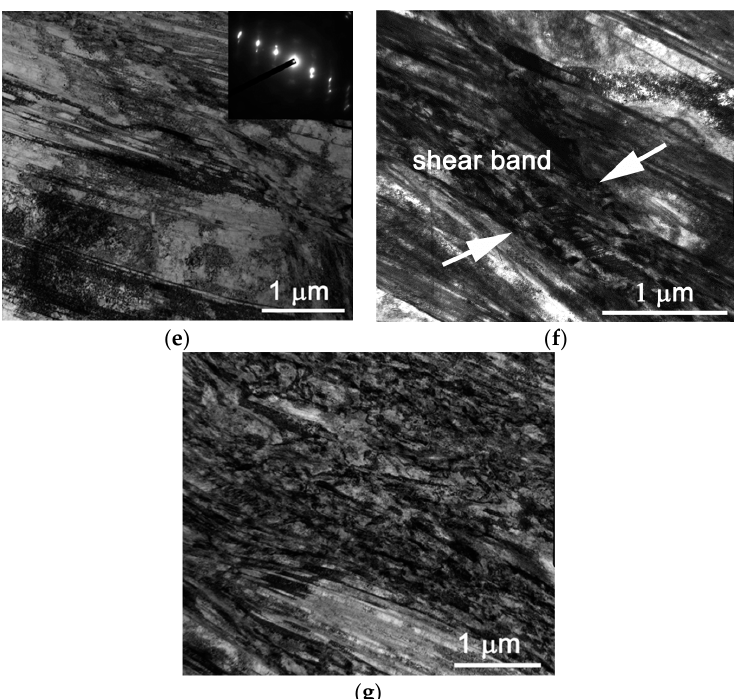
Figure 3. TEM bright-field images of the microstructure of the Al-, C-containing CoCrFeNiMn-type alloy after rolling with different thickness reduction: ( a ) 5%; ( b ) 10%; ( c , d ) 20%; ( e ) 40%; ( f ) 60%; and ( g ) 80%. Rolling direction (RD) is identified with the arrow in Figure 3a.